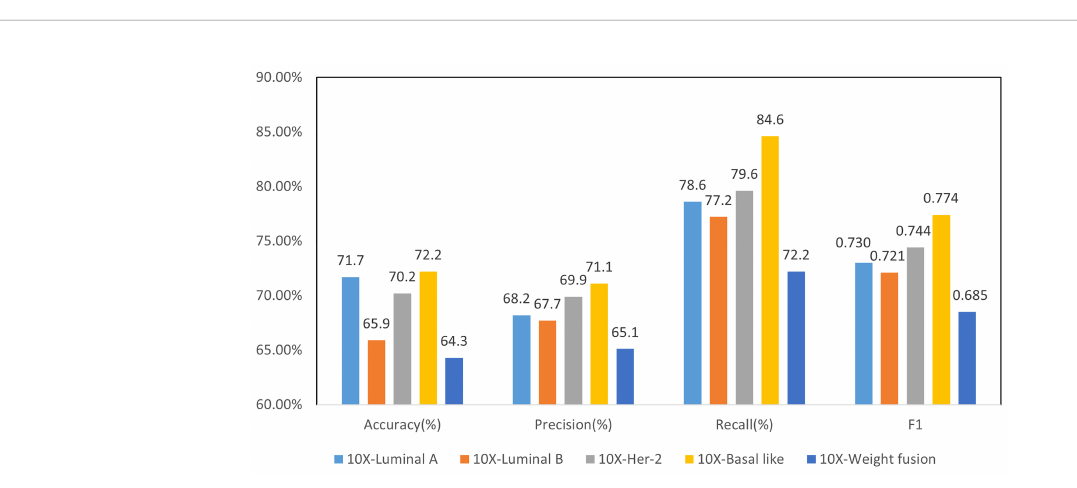
FIGURE 8 | Results of 2-class molecular subtype classi fi cation and 4-class weighted fusion at 10× resolution.